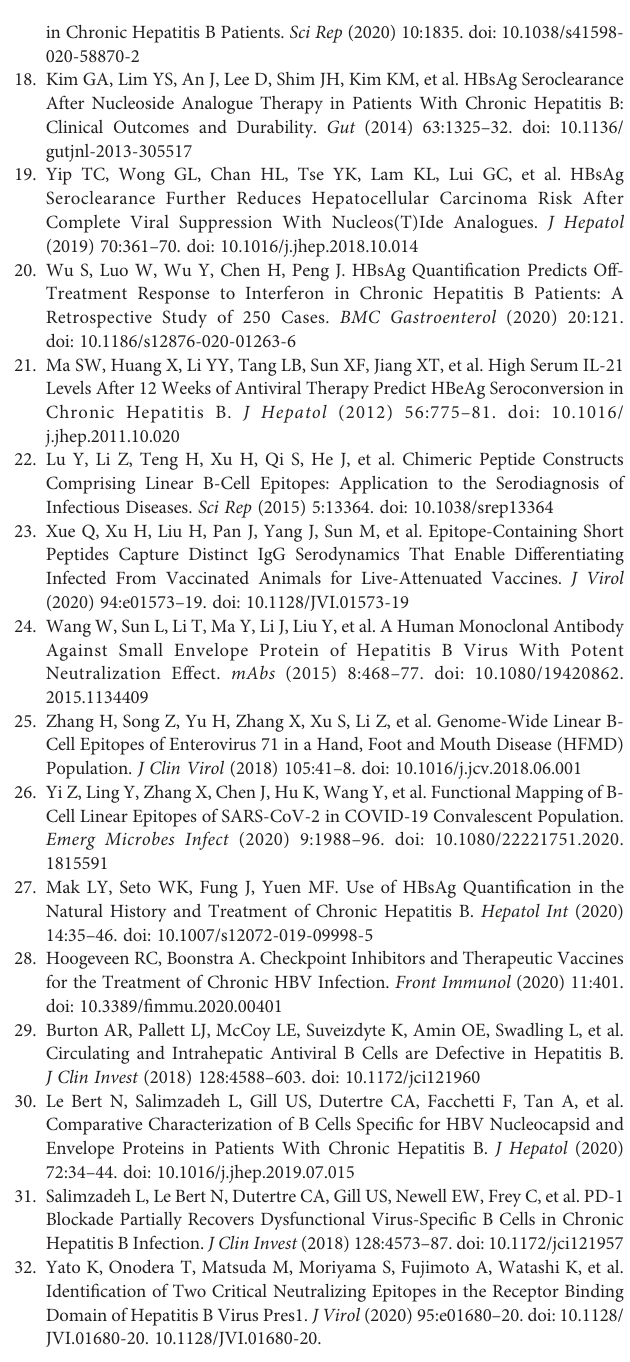
Supplementary Figure 2 | Comparing the number of positive epitopes in patients with chronic HBV infection in different subpartitions.